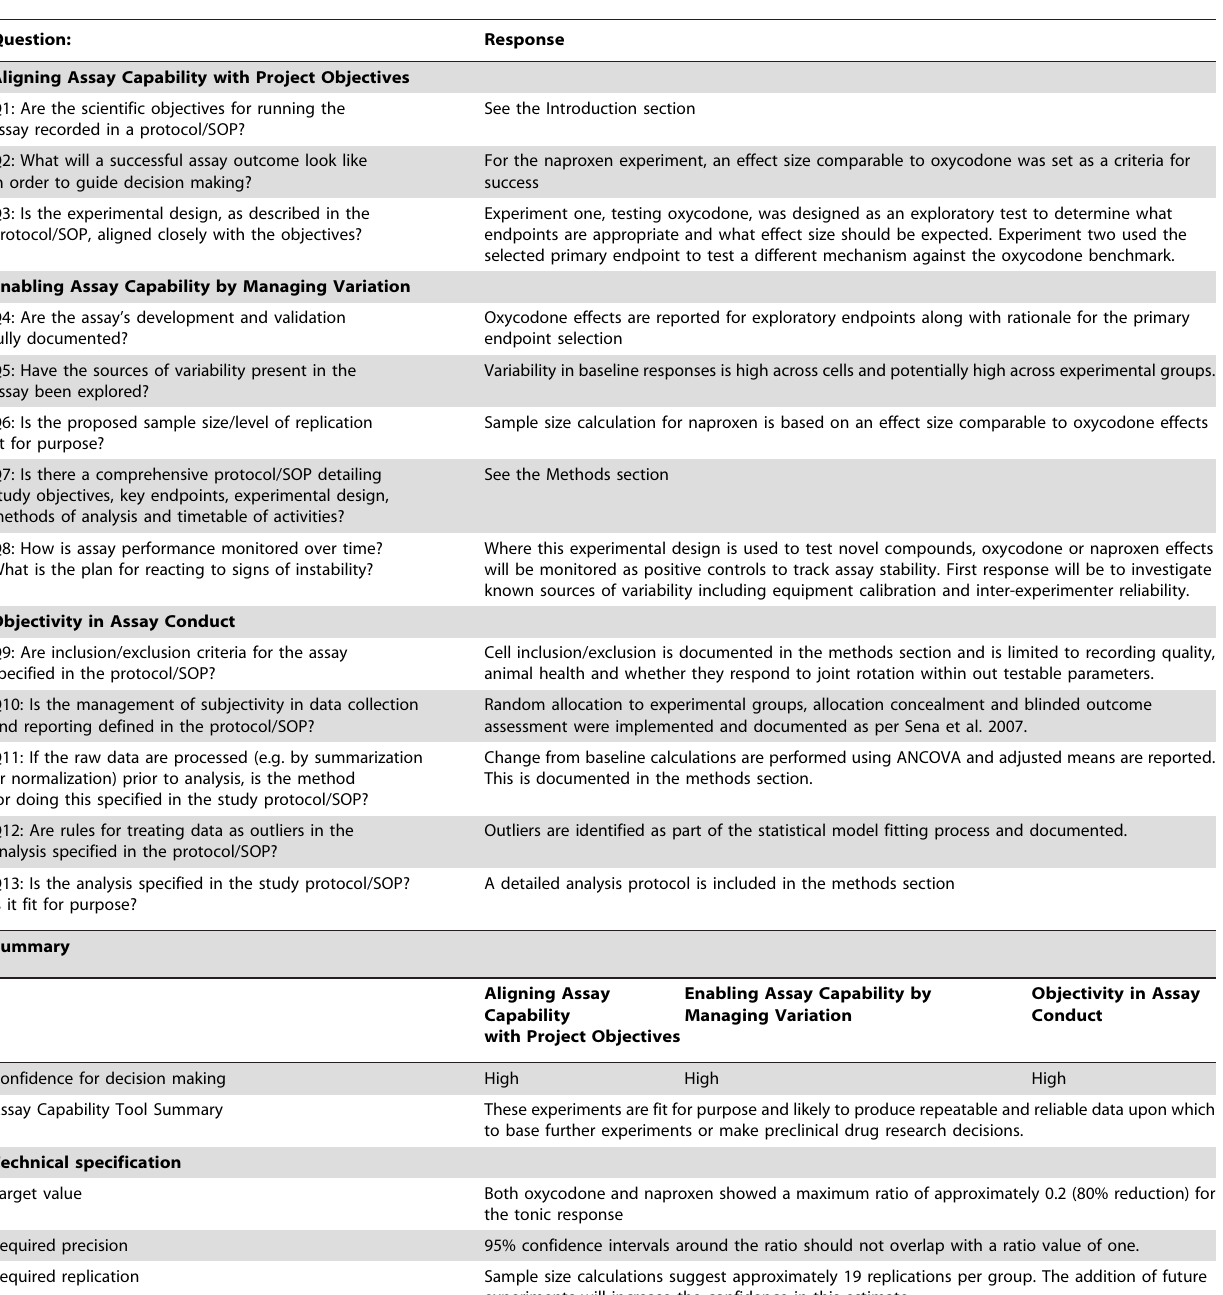
Table 2. Assay Capability Tool applied to the joint rotation